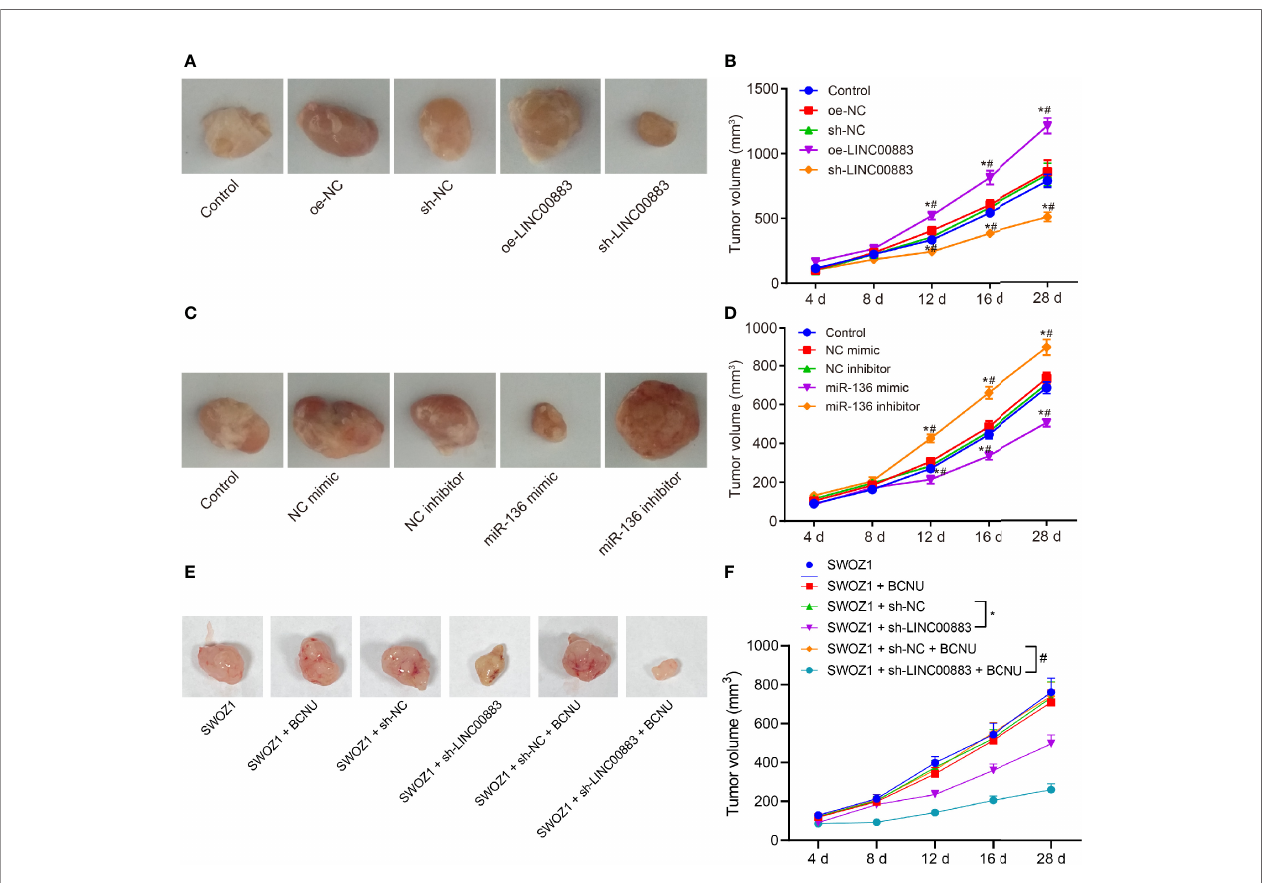
FIGURE 4 | Silencing of LINC00883 or overexpression of miR-136 represses the tumorigenicity of drug-resistant cell line U251. (A) The transplanted tumors of nude mice after overexpressing or silencing LINC00883. (B) The effect of overexpressing or silencing LINC00883 on tumor volume. (C) The transplanted tumors of nude mice after overexpressing or silencing miR-136. (D) The effect of overexpressing or silencing miR-136 on tumor volume. (E) Representative images showing xenografts in nude mice inoculated with SWOZ1 cells with sh-LINC00883 or/and treated with BCNU. (F) Tumor volume of mice inoculated with SWOZ1 cells with sh-LINC00883 or/and treated with BCNU. * p < 0.05 vs . the control or SWOZ1 + sh-NC group; # p < 0.05 vs . the oe-NC, SWOZ1 + sh-NC + BCNU or NC mimic group; vs . the sh-NC or NC inhibitor group. The values of tumor volume were measurement data, which were expressed as mean ± standard deviation and analyzed by repeated-measures analysis of variance. n = 5 mice in each group. Biological and technical experimental replicates were performed in